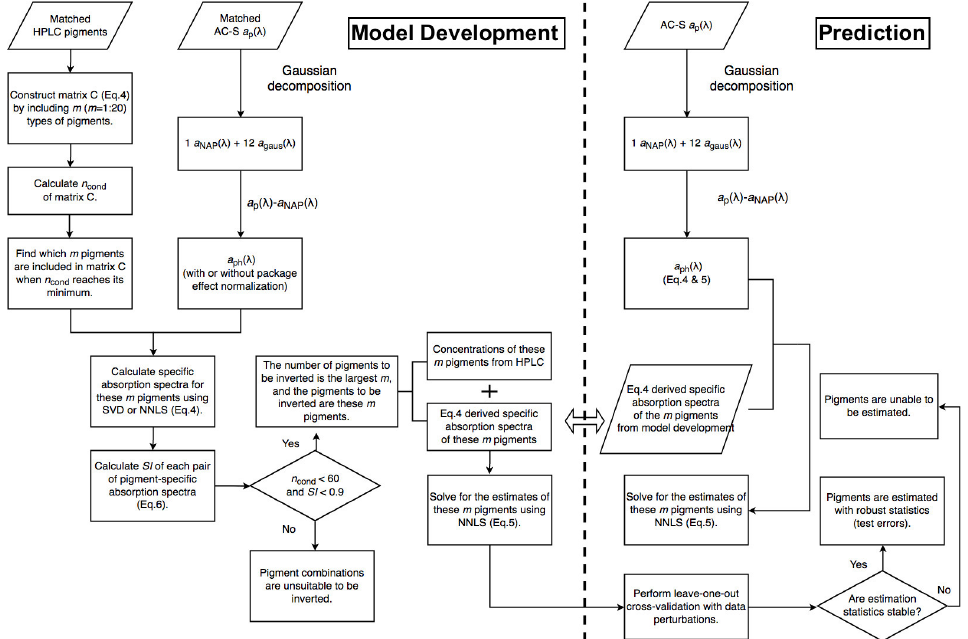
Figure 3. Schematic overview of the steps of applying the matrix inversion technique for phytoplankton pigment